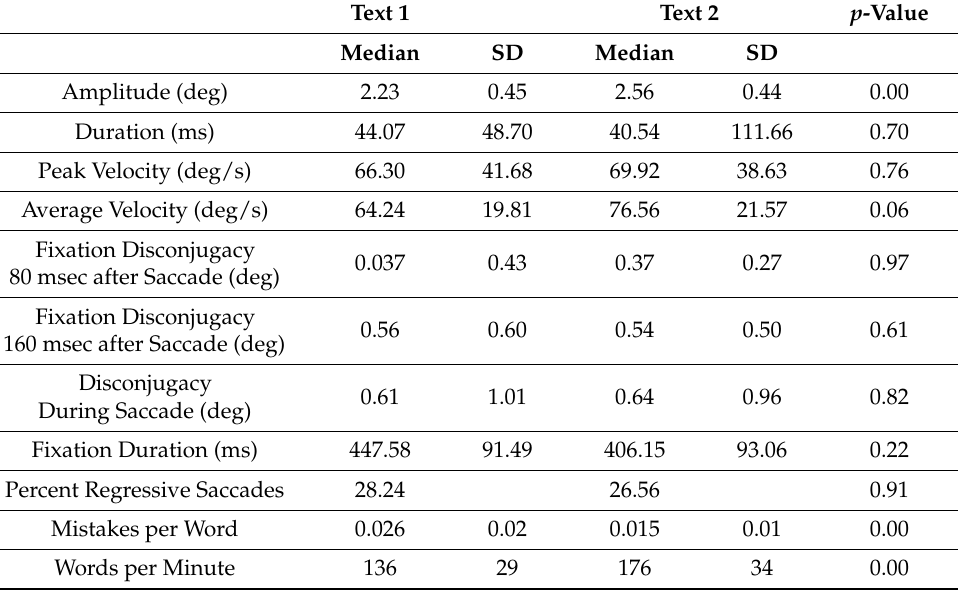
Table 4. Comparing Texts in the Control